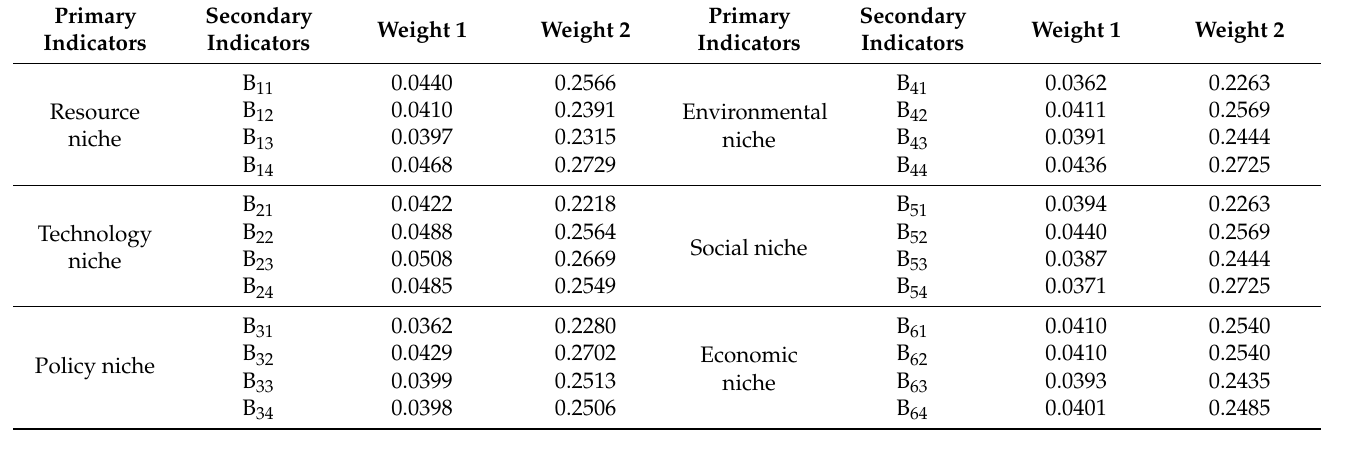
Table 6. Weights of secondary indicators.